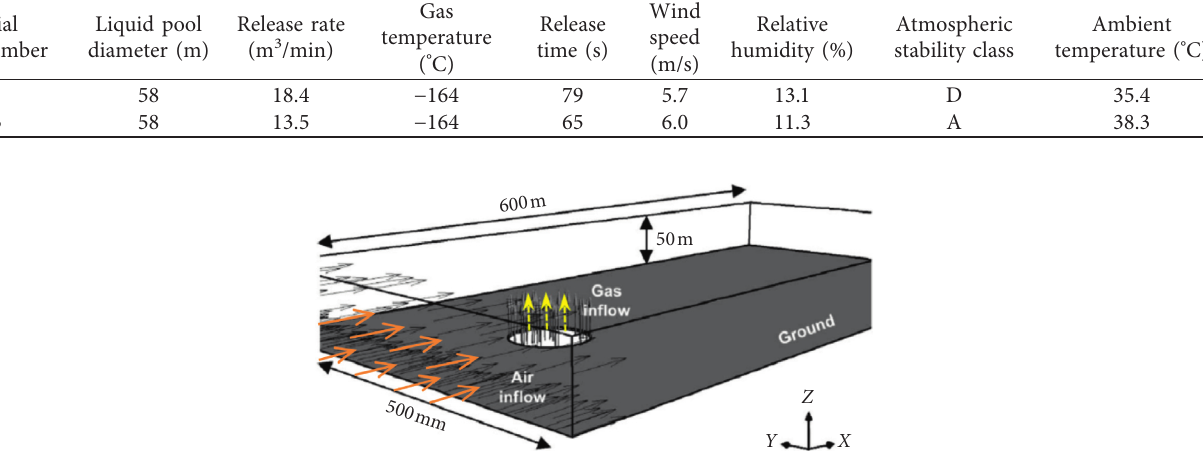
Figure 3: Computational domain size and boundary conditions [28, 29].